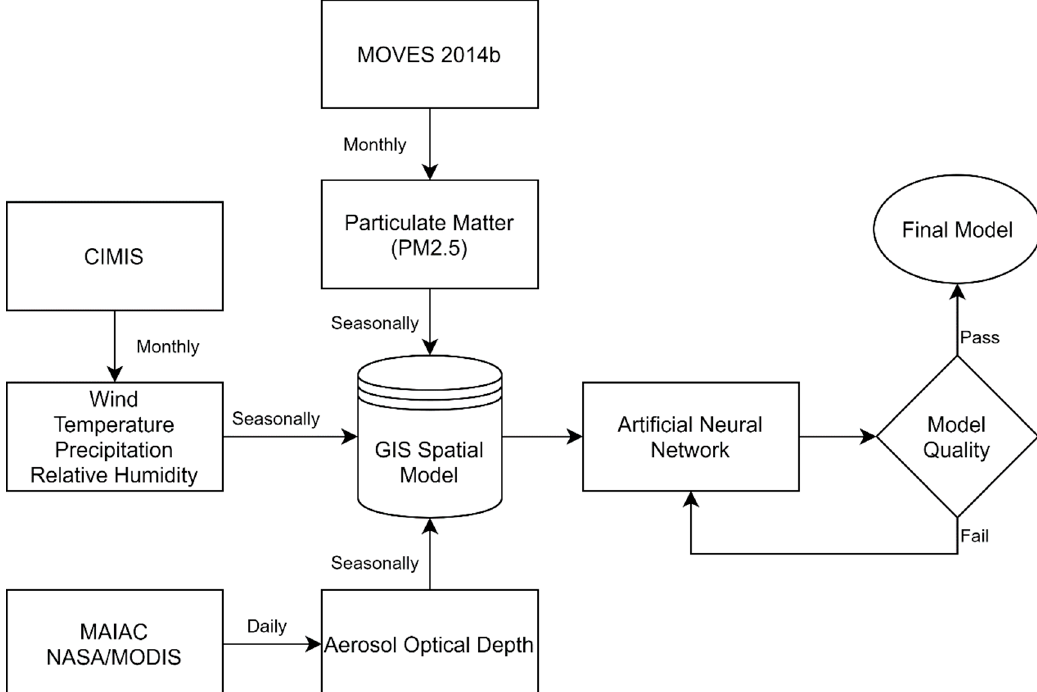
Figure 2. Project overview. PM2.5: particulate matter of size 2.5 µm (PM2.5); CIMIS: California Irrigation Management Information System; MODIS: Moderate Resolution Spectroradiometer; MOVES: Motor Vehicle Emissions Simulator; MAIAC: Multi-Angle Implementation of Atmospheric Correction.